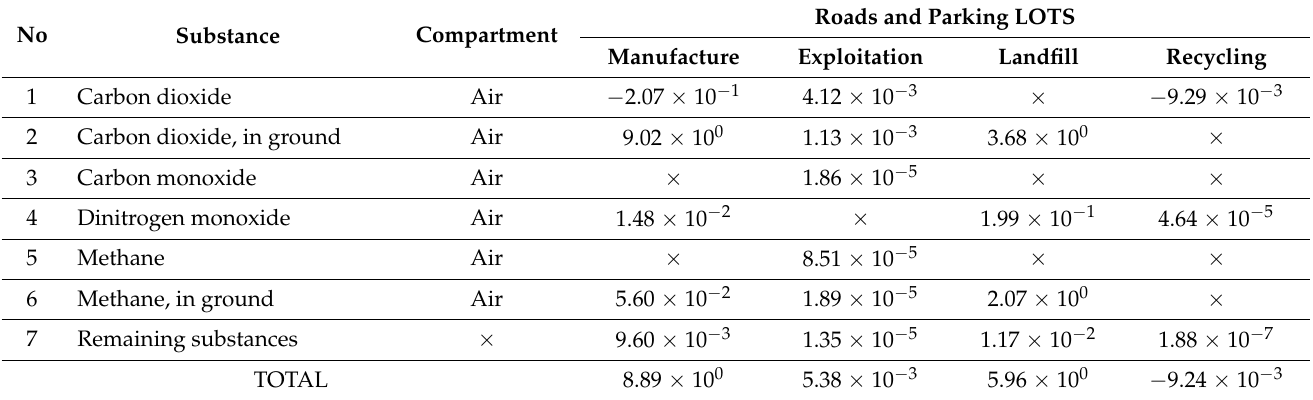
Table 15. The results of grouping and weighing the environmental consequences of emissions of compounds causing climate change due to roads and parking lots occurring at individual stages of the life cycle of the research